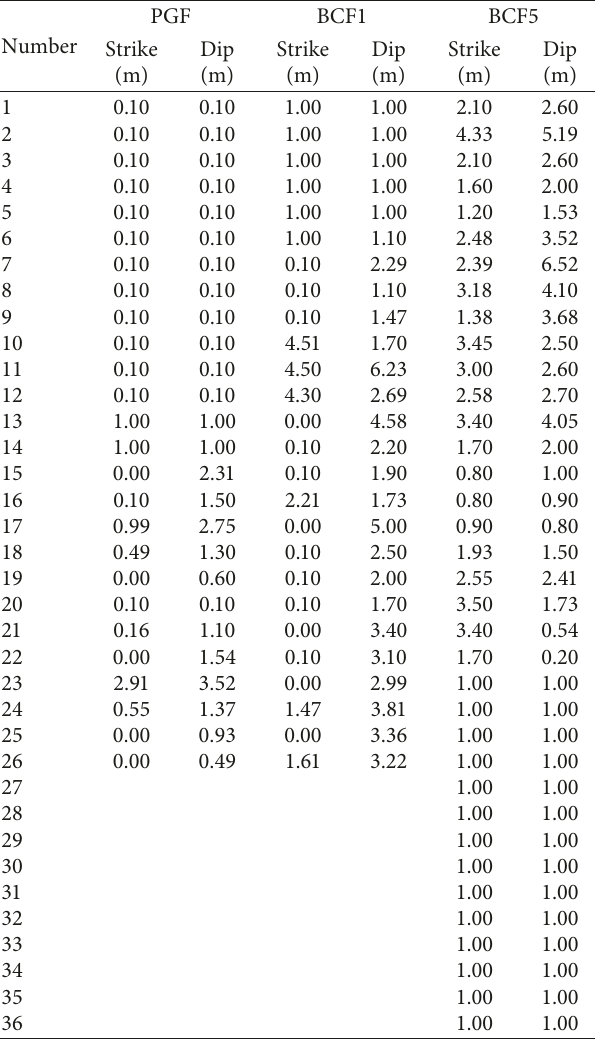
Table 3: Slip values constraint of shallowest subfaults of BCF and PGF.